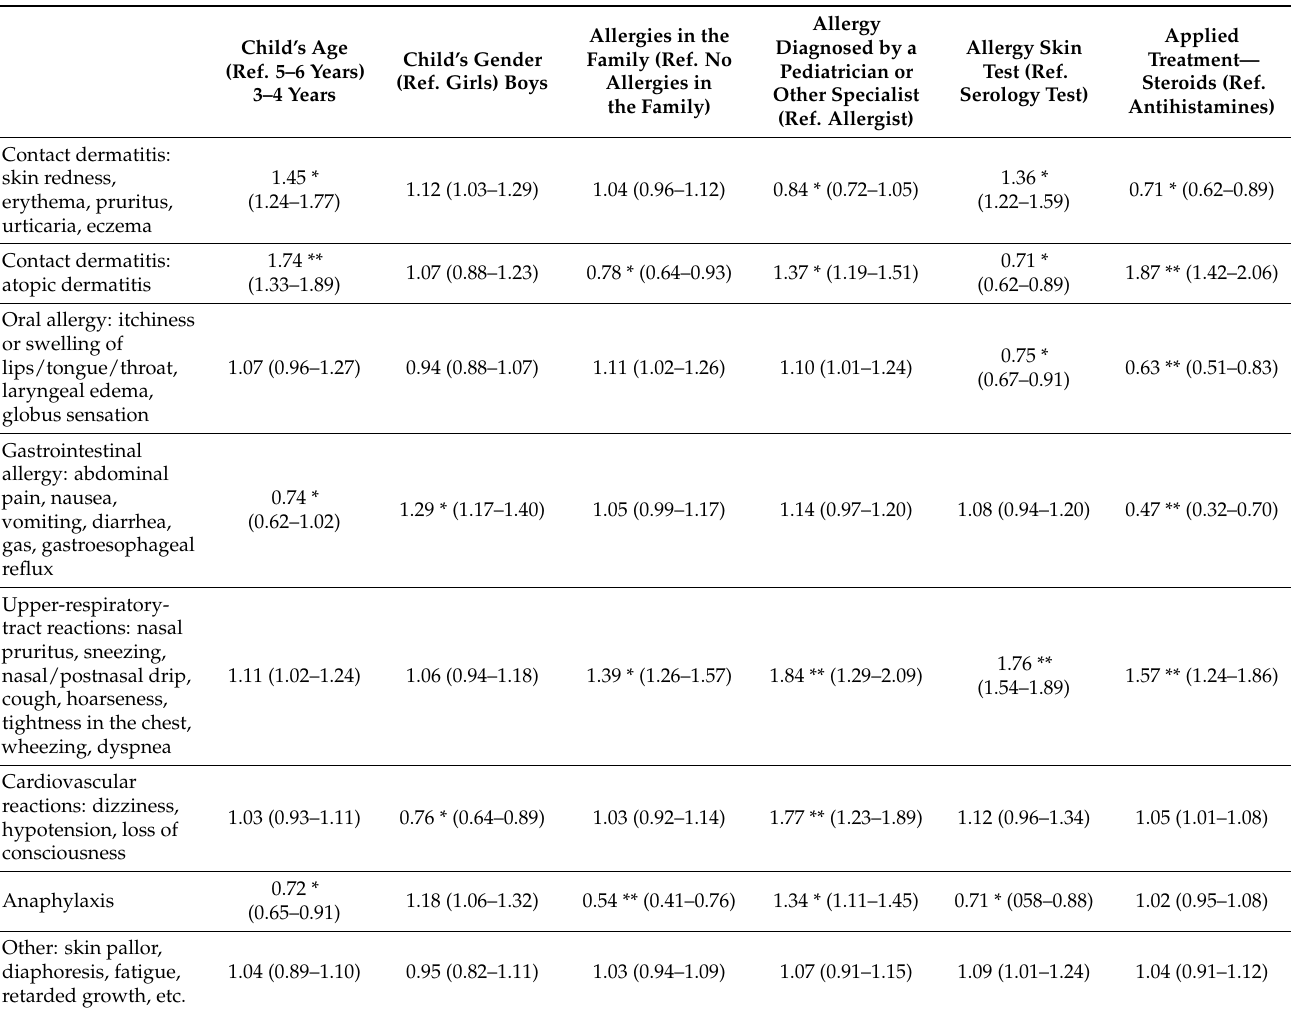
Table 2. Odds ratios (95% confidence interval) of the relationships between selected allergy-related factors and